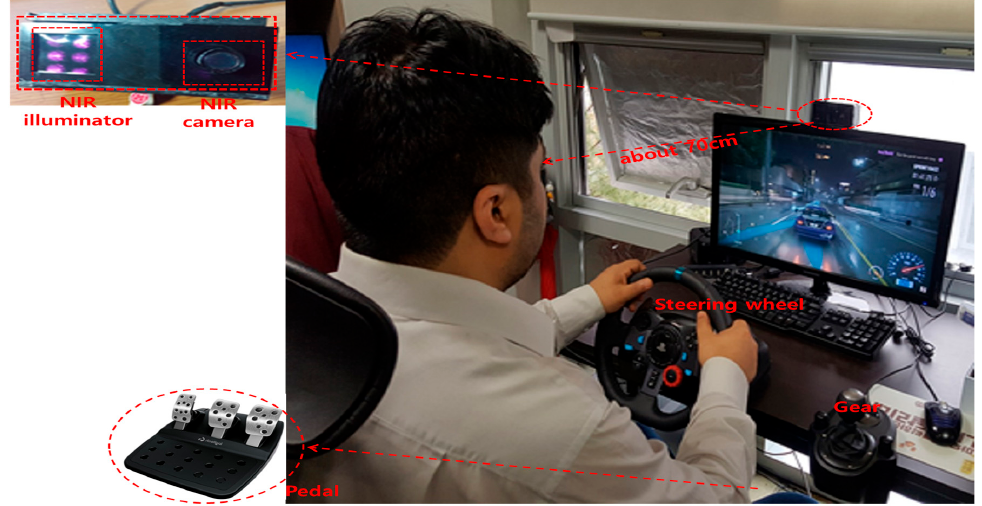
Figure 2 . Experimental environment and proposed prototype for driving behavior classification. Figure 2. Experimental environment and proposed prototype for driving behavior